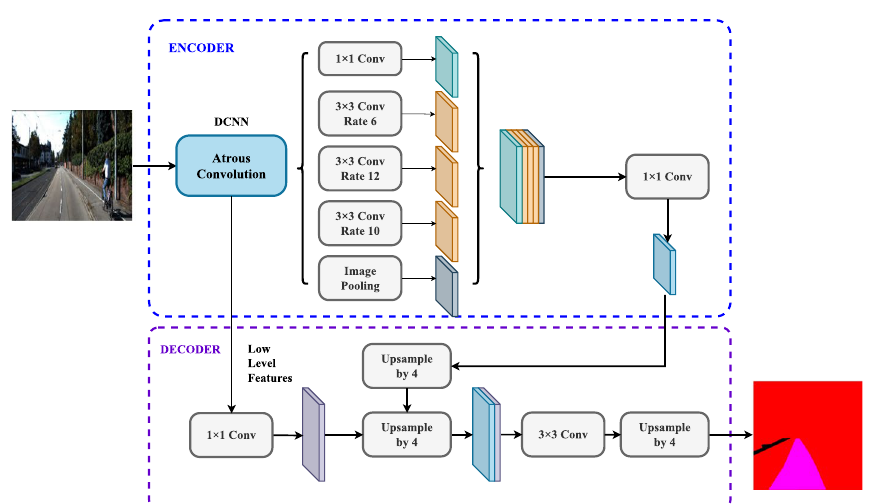
Fig. 7 Encoder-decoder of DeepLabV3